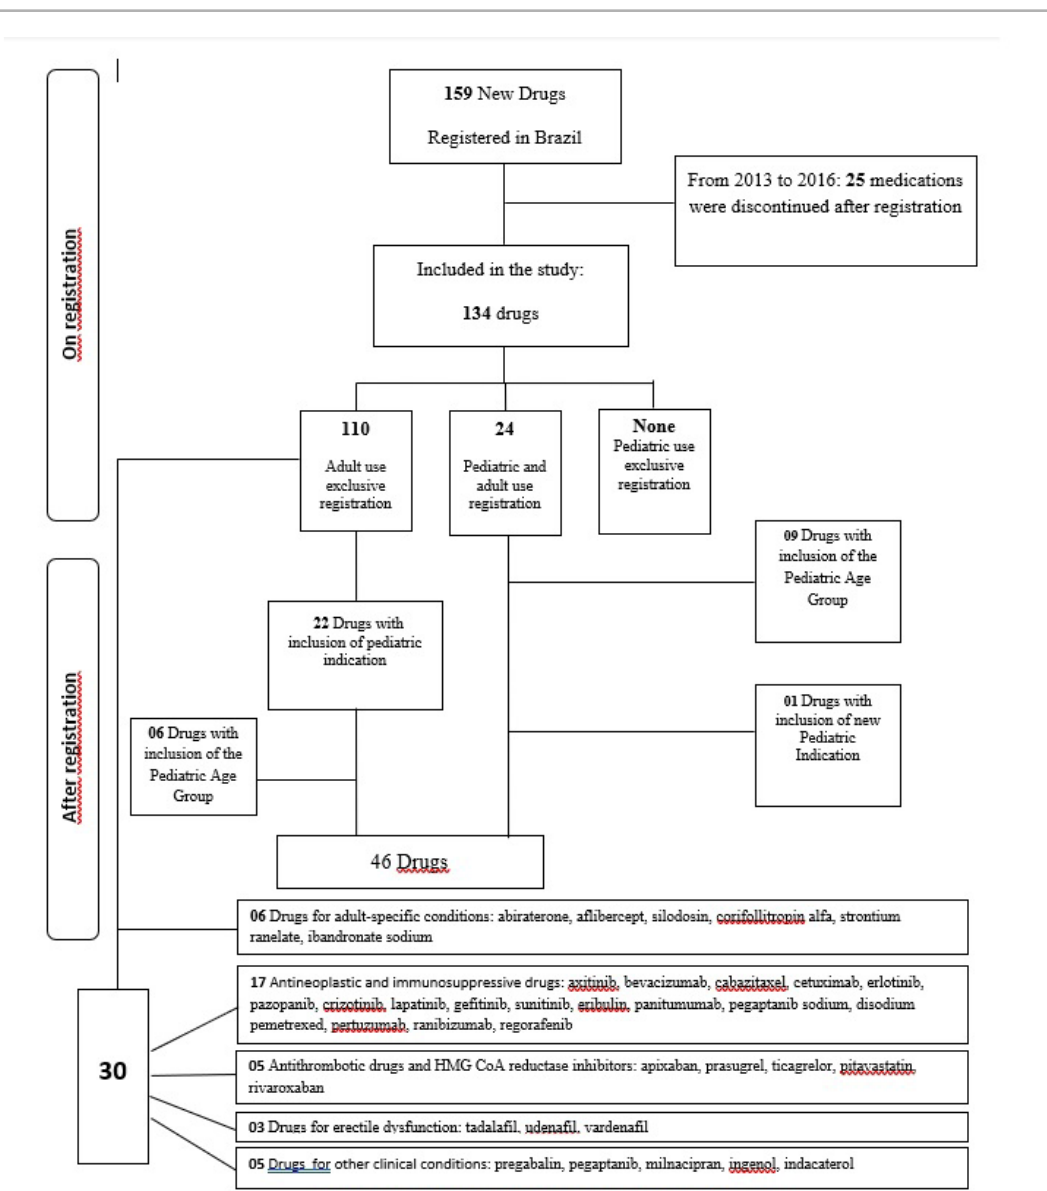
FIGURE 1 – Flow chart of pediatric medicines from 2003 to 2013.